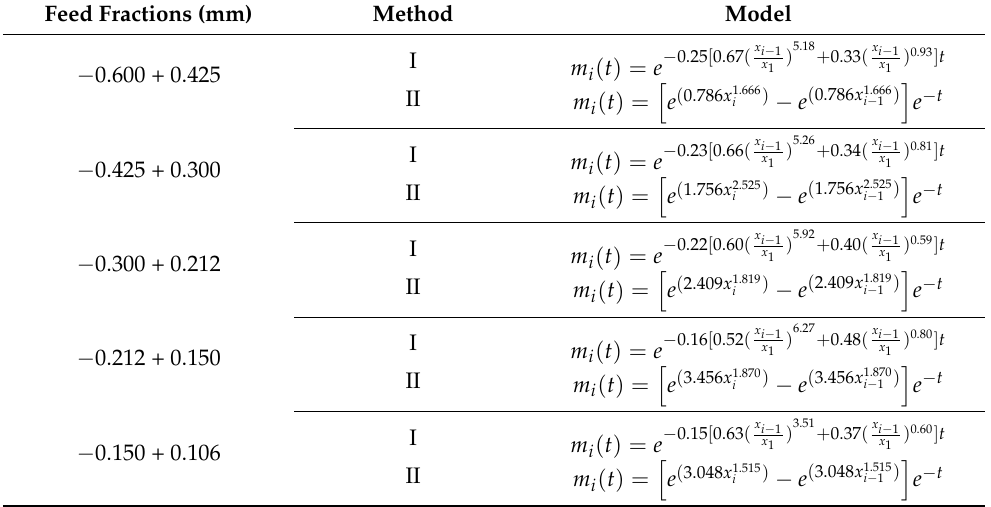
Table 7. The model derived from the two methods for each of the feed fractions (i > 1).